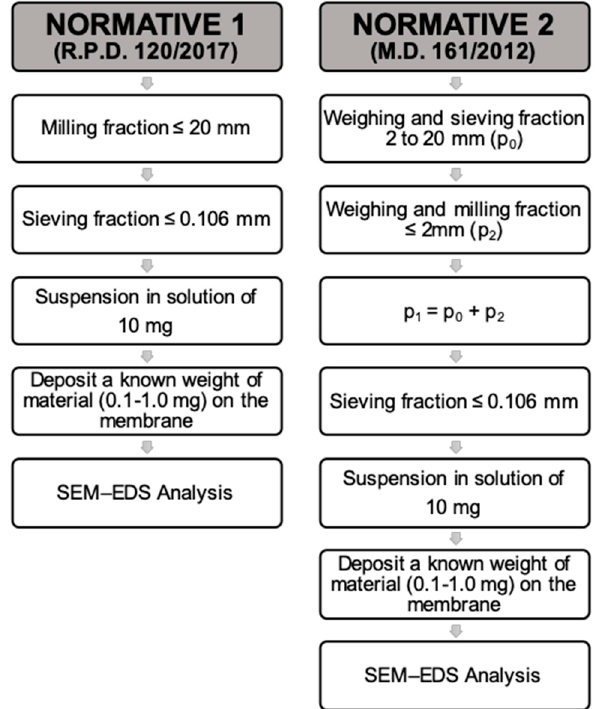
Figure 5. Flow diagram of the sample preparation steps according to Normative 1, R.P.D. 120/2017 (left) and Normative 2, M.D. 161/2012 (right).